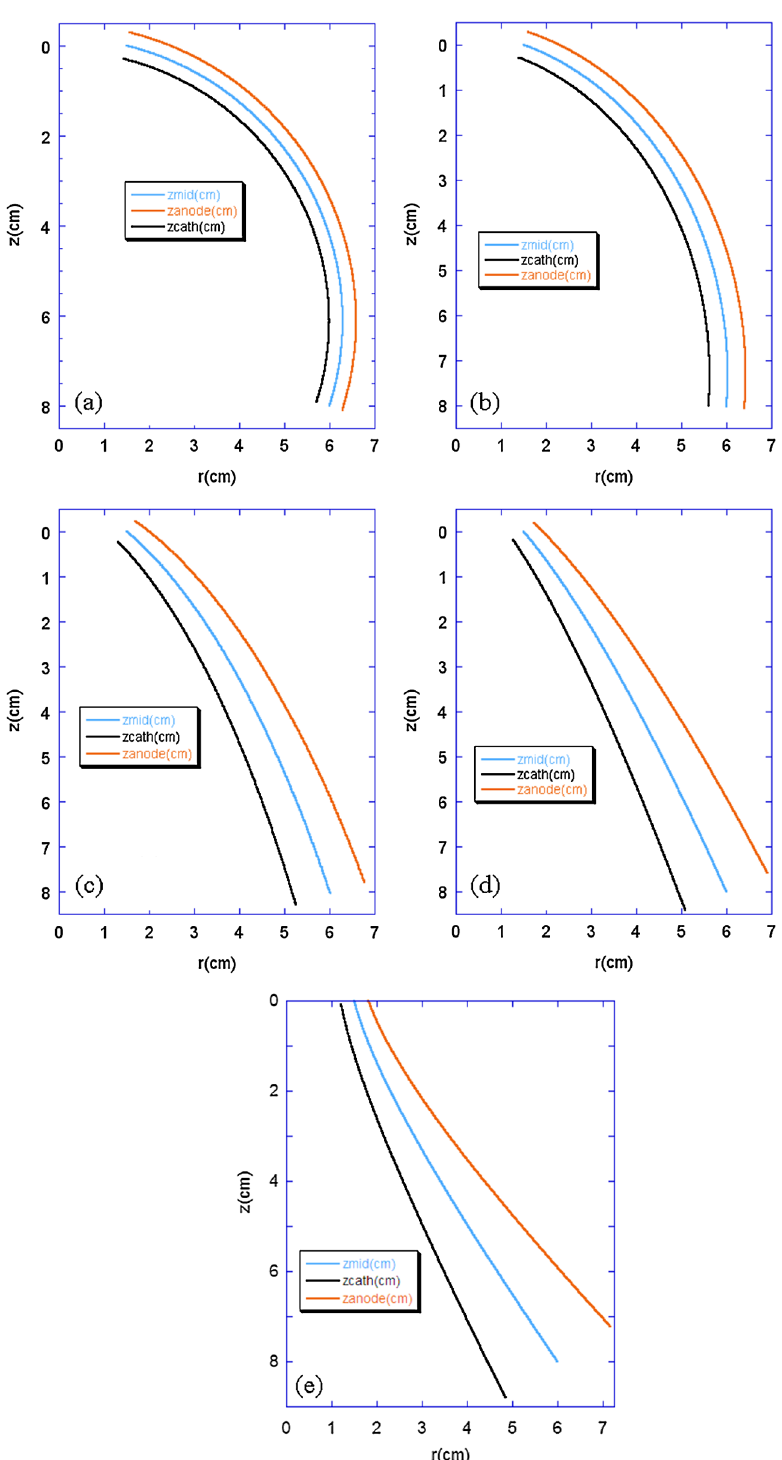
FIG. 3. (Color) Electrode and midgap curves for optimal TL (cathode in black, anode in red, midgap in blue) of gaps varying linearly with radius. They all have the same inner end point and outer end points at r cases the inner point gap is 0.6 cm. The outer midgap end point gap is varied: (a) solution in Ref. [4], 0.6 cm, (b) 0.8 cm, (c) 1.6 cm, (d) 2.0 cm, and (e) 2.8 cm. Notice the change of character of the optimal TL as the outer gap increases, from doubled-value midgap curve to straight-biconic-like, to changing from concave to convex in (e), as explained in the text. The vacuum inductances of the optimal TL in each of the plots compared to the straight-line TL are in nH as follows: ½ L (c) [5.5, 5.6], (d) [6.4, 6.5], and (e) [8.2,